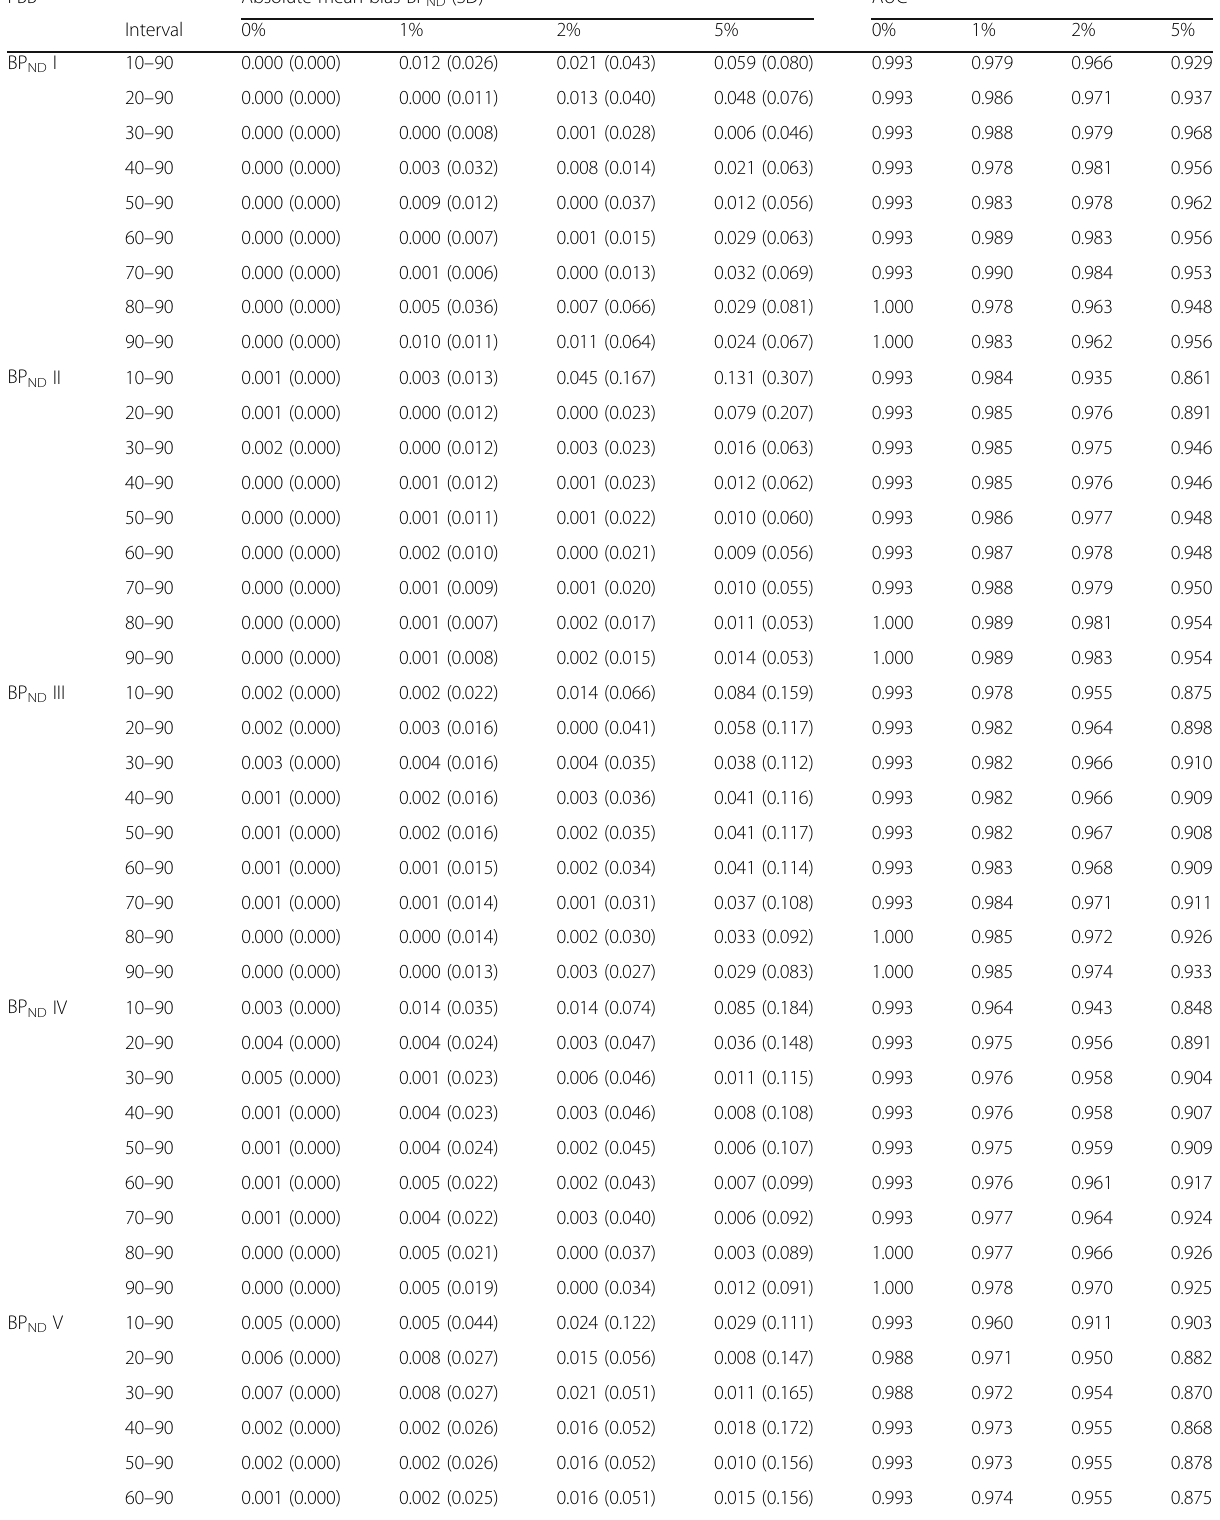
Table 6 Absolute bias in BP ND and AUC as a result of noise and the dual-time-window protocol for